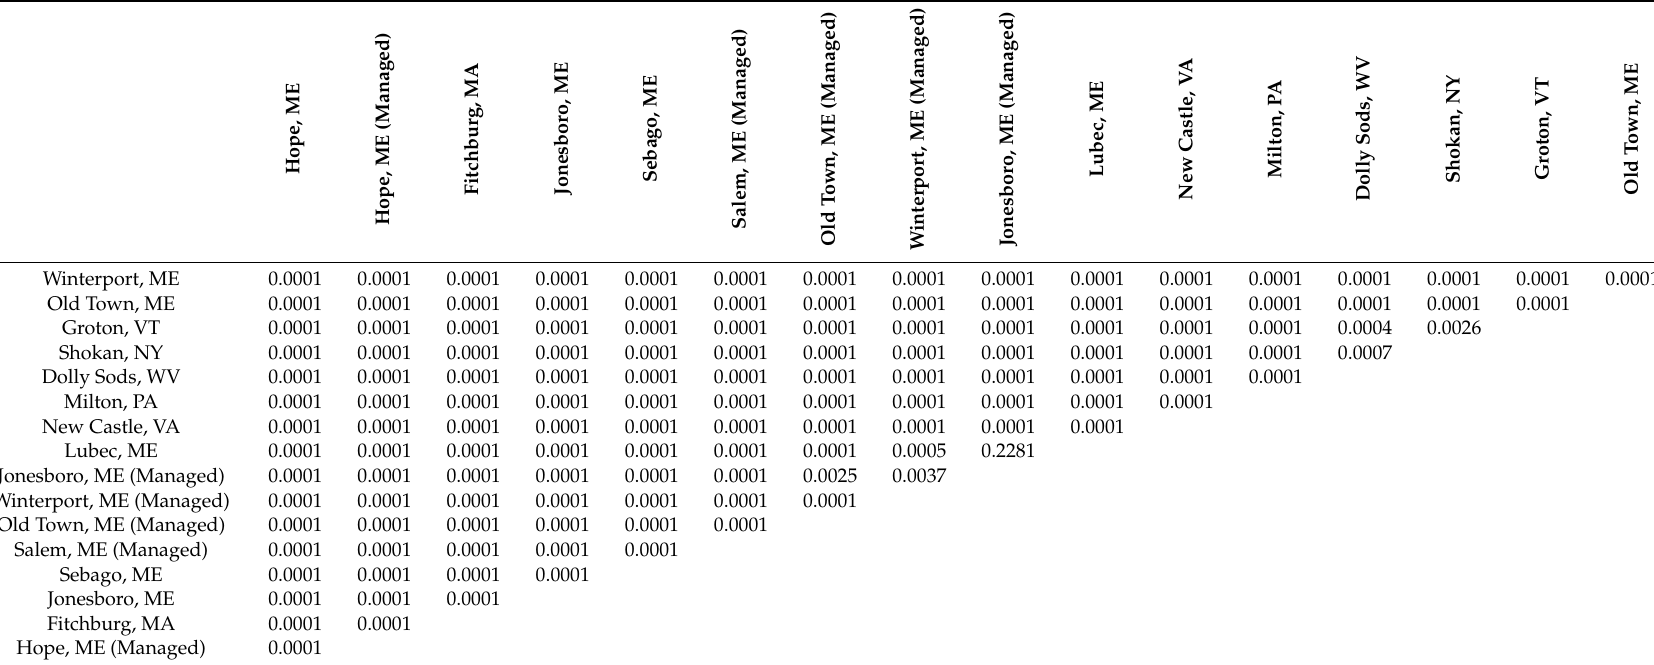
Table 5. Pairwise comparison via AMOVA with 9999 permutations for all sampled populations. Significant di ff erences exist between sampled populations (cut-o ff for Bonferoni pairwise comparisons that maintains an experiment-wise error of p = 0.05 is p ≤ 0.0136) with the exception of the non-managed Lubec, ME and managed Jonesboro, ME, populations ( p =